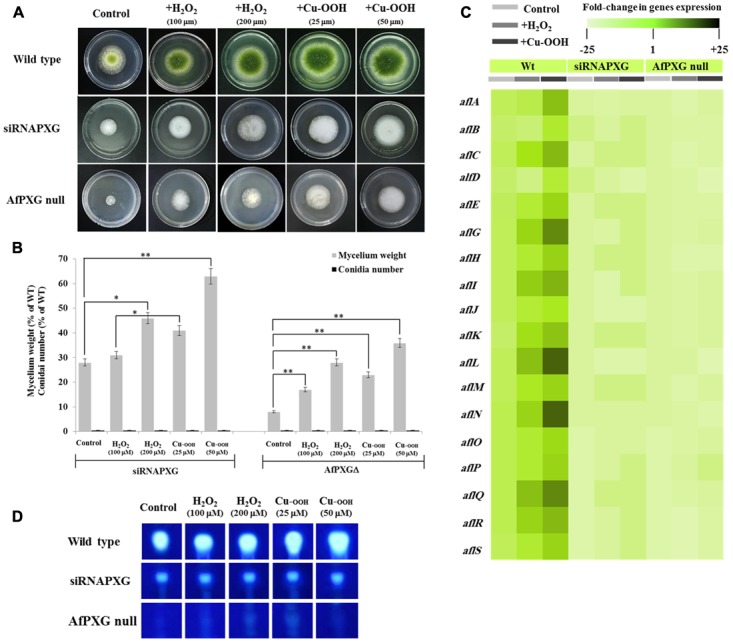
Increasing oxidative status does not restore the AfPXG-mutant phenotype. (A) Effect of H2O2 and cumene hydroperoxide (Cu-OOH) on the morphology of fungal phenotypes grown on PDA plates for 4 days at 28°C. Fungal growth was incubated with H2O2 and Cu-OOH at the indicated concentration. (B) Evaluation of fungal biomass (light-gray columns) and conidia number (black columns) for both lines, siRNAPXG2 and AfPXGΔ. Fungal biomass from each of the AfPXG-deficient lines exposed to H2O2 or Cu-OOH was significantly different from those of non-treated lines when analyzed by t-test (∗P < 0.05; ∗∗P < 0.01). (C) Relative quantification of transcript levels of AFB1-biosynthesis genes in AfPXG-deficient lines as a function of treatments with H2O2 (200 mM) or Cu-OOH (50 mM) compared with controls. For each gene, the transcript level was evaluated by qRT-PCR as described in Section “Materials and Methods.” Three measurements were taken in three cDNAs prepared from three individual fungal growth for each treatment. The color scale (white–green–black) indicates relative changes of transcript abundance of –25-, 1-, and +25-fold, respectively. For each gene, the expression level in WT unexposed to H2O2 or Cu-OOH was defined as 1, and the corresponding abundance changes under treatments were calculated directly using software installed in the Applied Biosystems qPCR system. (D) TLC-analysis of AFB1 produced by AfPXG-deficient lines as a function of treatment with H2O2 or Cu-OOH compared with controls.